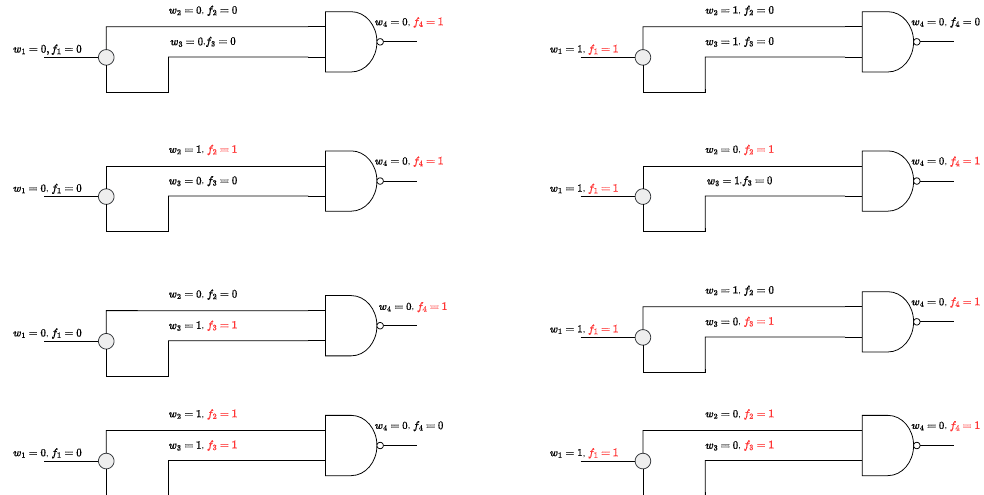
Figure 1. All possible valid fault configurations for a small circuit with one FAN gate and one NAND gate that has a faulty output. The diagrams on the top left and right show minimum fault explanations for this